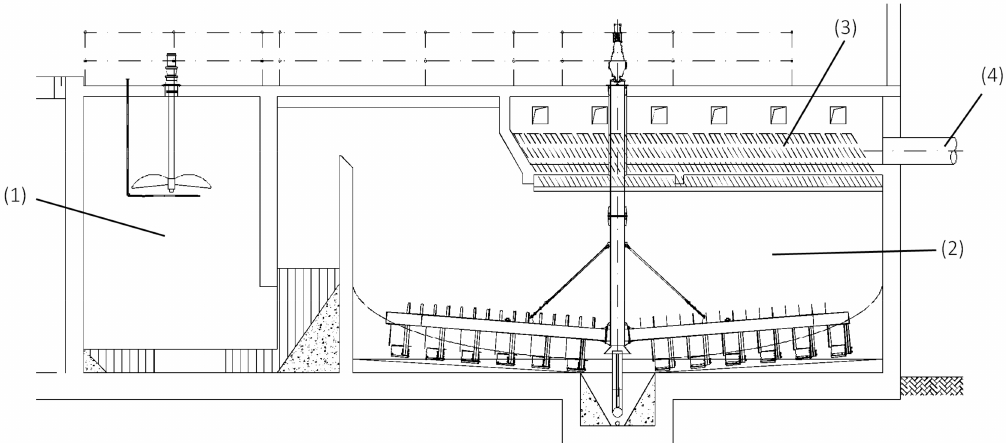
Figure 1. The installation of a combined flocculation and sedimentation chamber; (1—flocculation chamber; 2—settling tank; 3—system of lamella plates; 4—clarified water installation